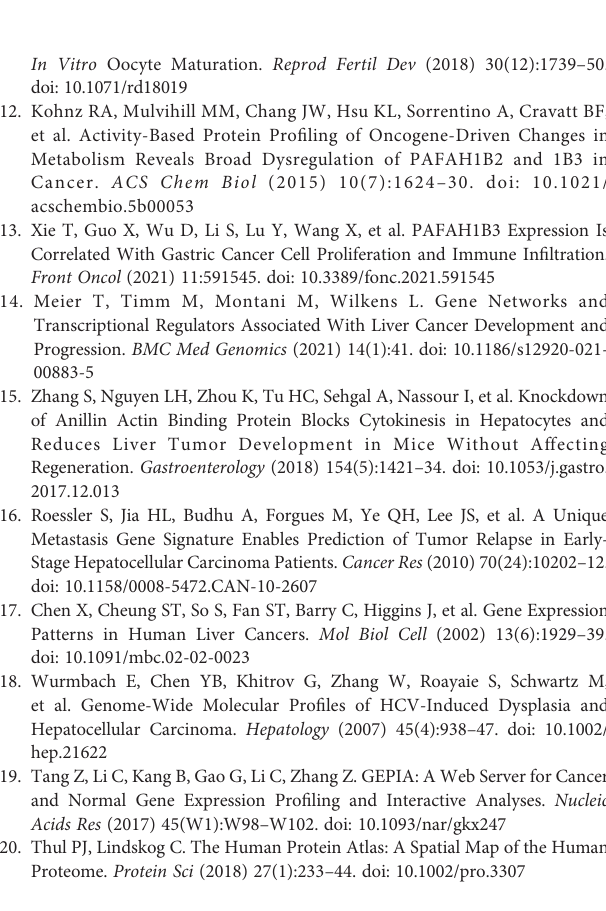
Supplementary Figure 1 | Prognostic Value of PAFAH1B3 in various cancer types. Overall survival of PAFAH1B3 was analyzed using GEPIA database in (A) adrenocortical carcinoma. (B) acute myeloid leukemia, (C) lung adenocarcinoma, (D) mesothelioma, (E) sarcoma, (F) skin cutaneous Melanoma. Supplementary Figure 2 | Gene ontology annotations and KEGG pathways enriched with PAFAH1B3 Co-expressed genes in hepatocellular carcinoma (LinkedOmics). GSEA was used to analyze the signi fi cantly enriched GO_BP, and KEGG pathways of PAFAH1B3 Co-expressed genes in LIHC. (A) Gene ontology biological processes, analyzed by GSEA. (B) KEGG pathway, analyzed by GSEA. The LeadingEdgeNum and the false discovery rate (FDR) are shown in blue and orange columns, respectively. Supplementary Figure 3 | Expression of PAFAH1B1 and PAFAH1B2 in HCC. Supplementary Figure 4 | Correlation between PAFAH1B3 expression and immune cell in fi ltration levels in HCC tissues analyzed via TIMER. Supplementary Table 1 | The statistics of PAFAH1B3 expression in LIHC based on ONCOMINE. Supplementary Table 2 | The top 50 co-expressed genes of PAFAH1B3